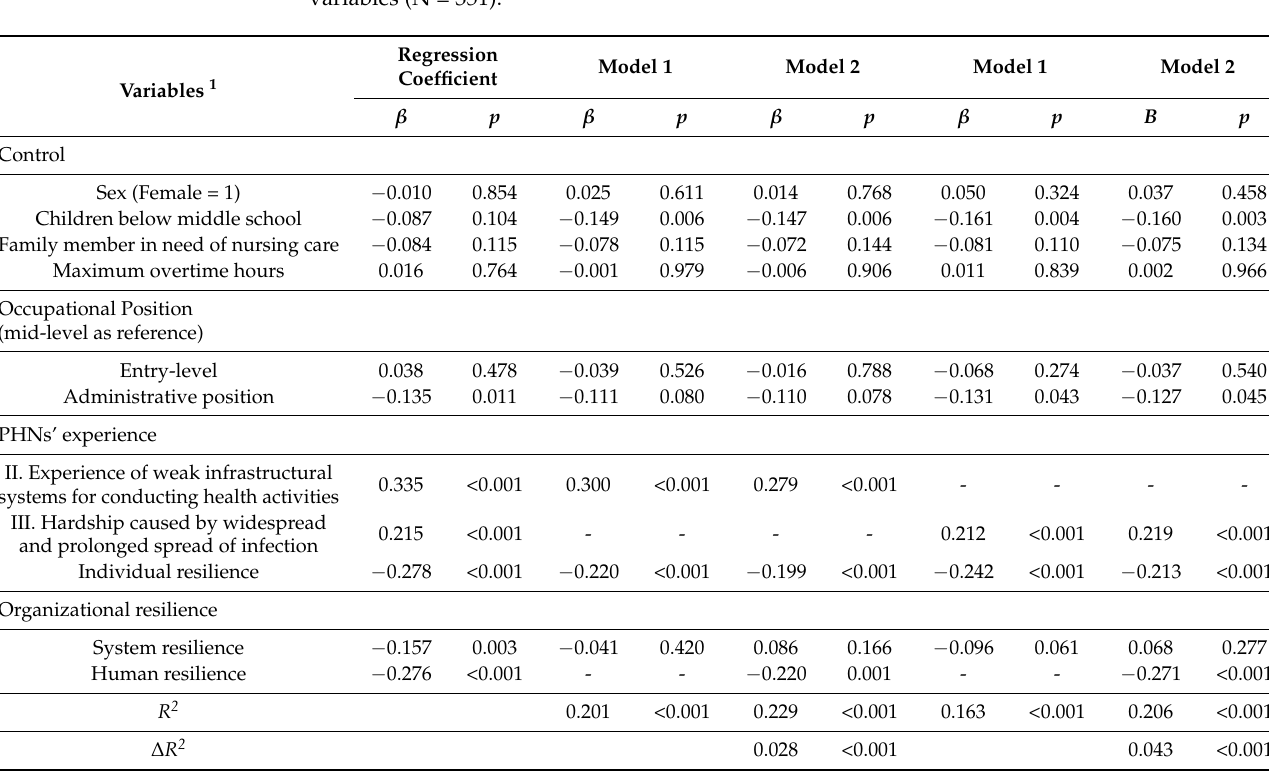
Table 6. Hierarchical multiple regression analysis with emotional exhaustion as the dependent variable, and experience, individual resilience, and organizational resilience as the independent variables (N =